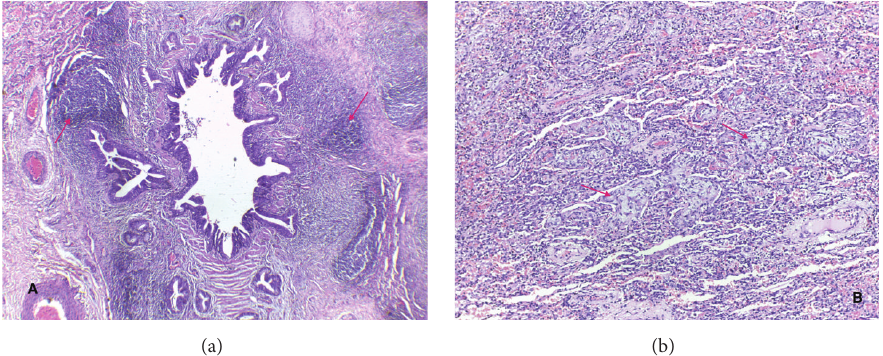
Figure 3: (a) Follicular bronchiolitis: hyperplastic lymphoid follicles with pale germinal centres (arrows) adjacent to a small bronchi and bronchioles (H&E × 40). (b) Organizing pneumonia: plugs of granulation tissue (Masson bodies) (arrows) within the alveolar ducts and spaces (H&E ×